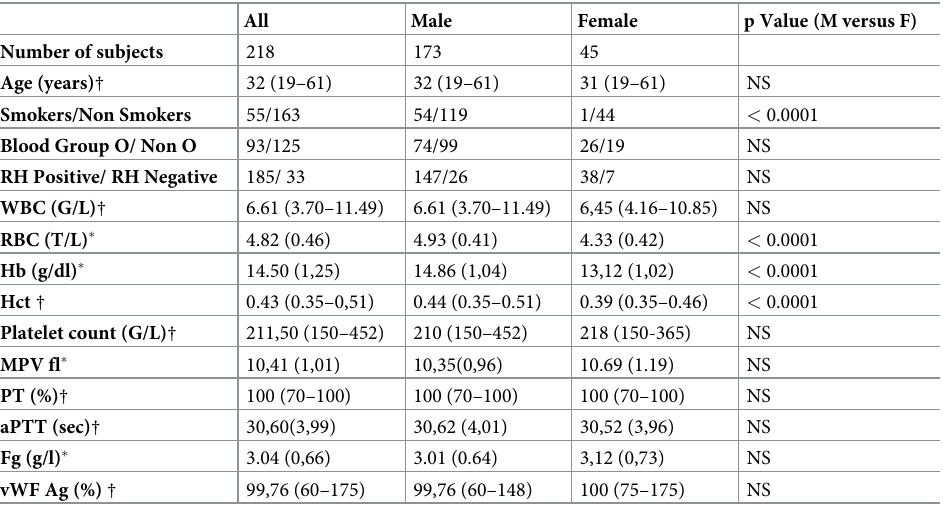
Table 1. Baseline data of 218 healthy